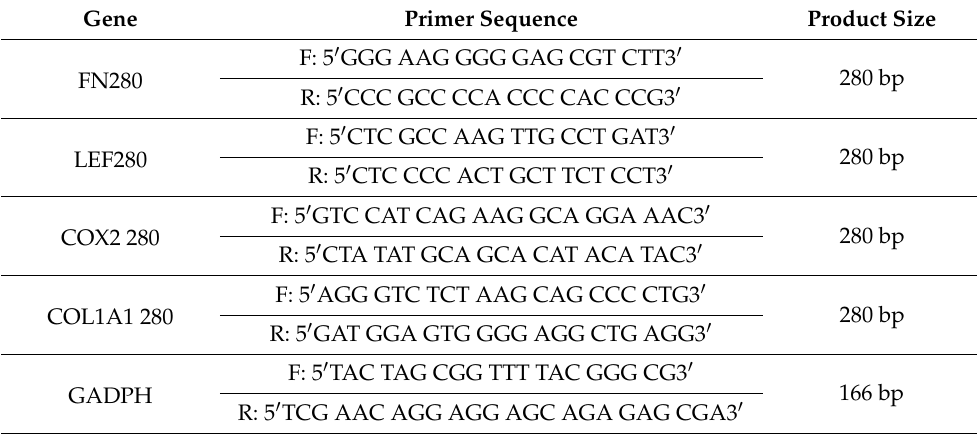
Table 1. Primers used for the ChIP